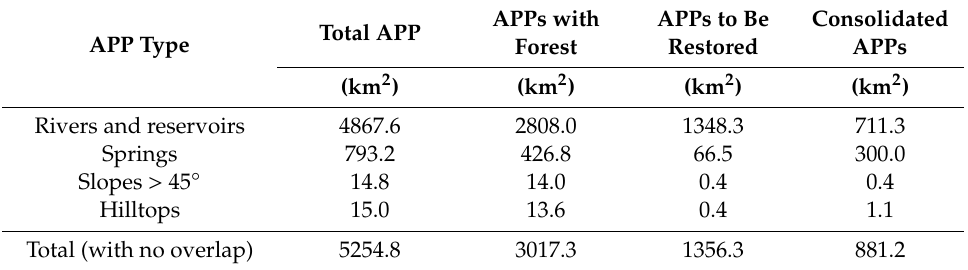
Figure 8. Estimated percentage of permanent preservation areas (APPs) with forest, consolidated, and to be restored, per APP type, across the Itacaiúnas watershed. Table 4. Permanent preservation area estimates, per permanent preservation area (APP) type, as